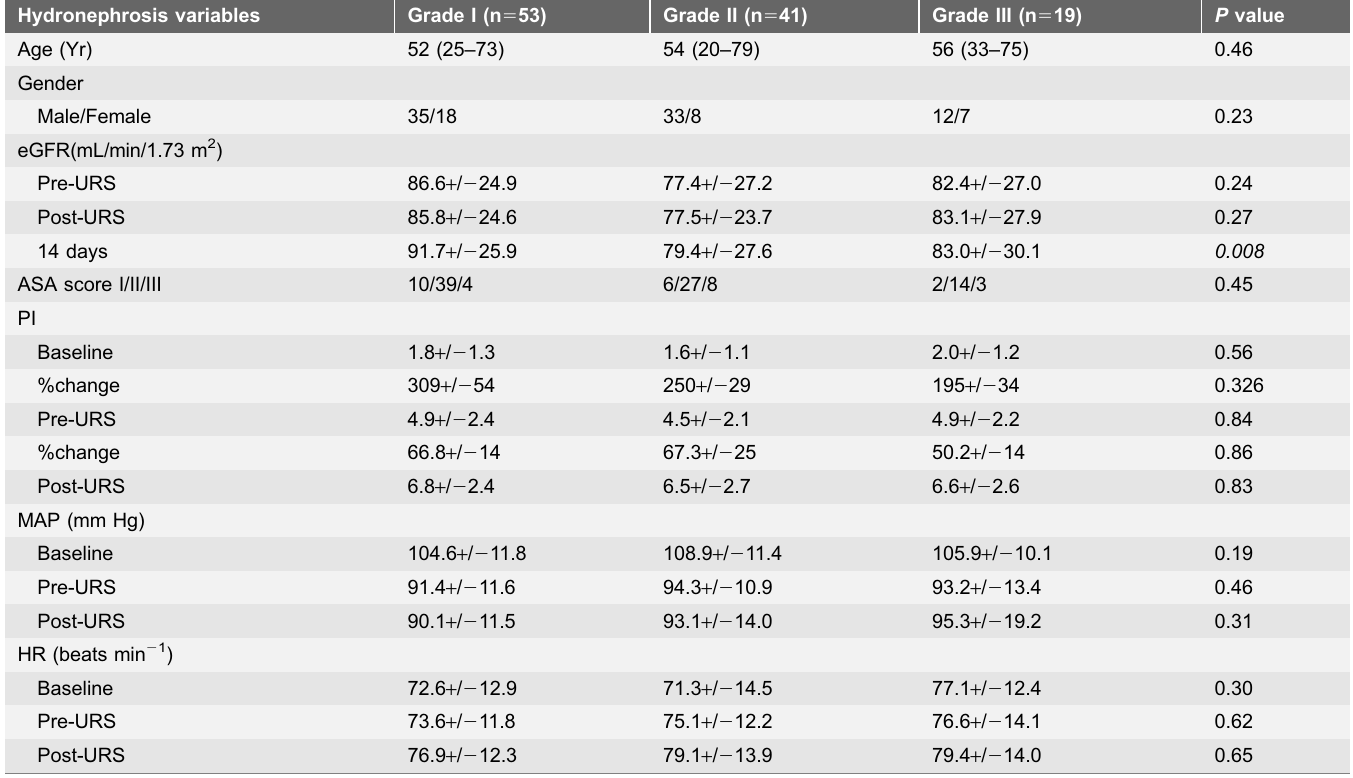
Table 1. Demographic data and the degree of